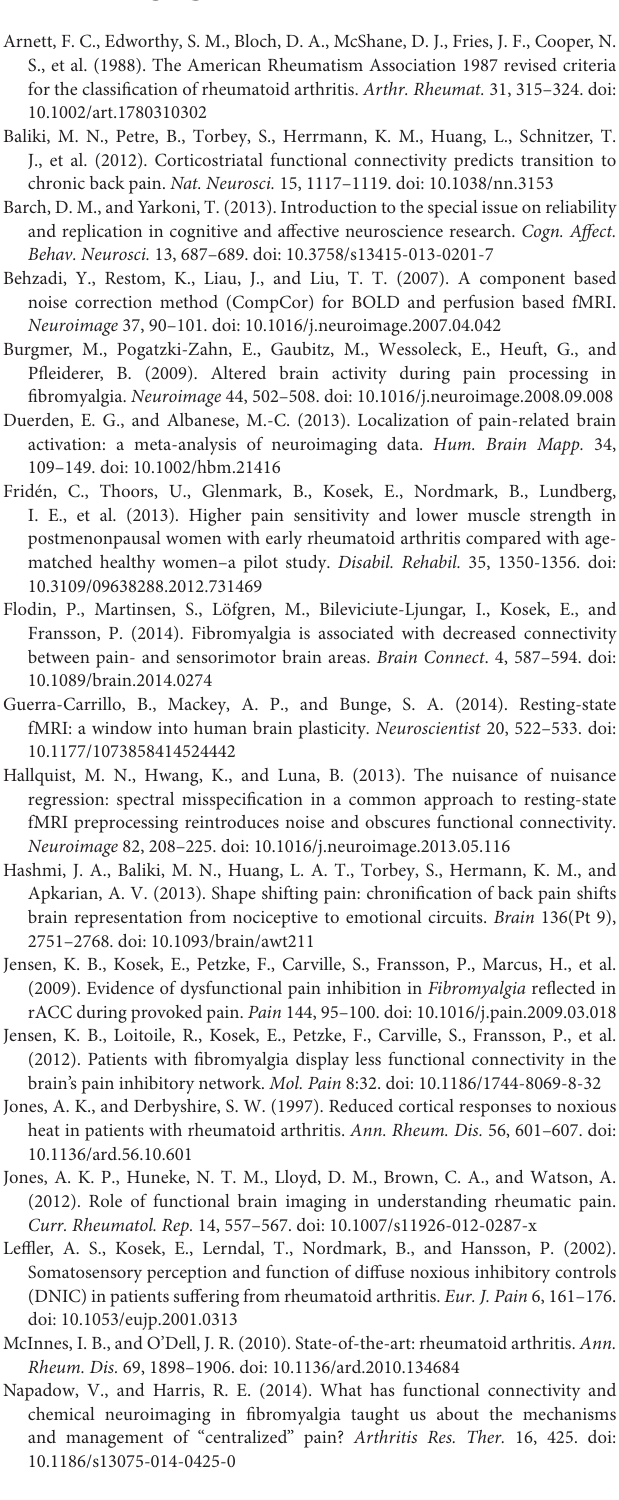
Supplemental Table S2 | The table shows MNI coordinates and anatomical labels of the 159 seed regions used in the seed correlation analyses. Anatomical labeling is performed using the automatic anatomical labeling (AAL) template in MRIcron. Stars